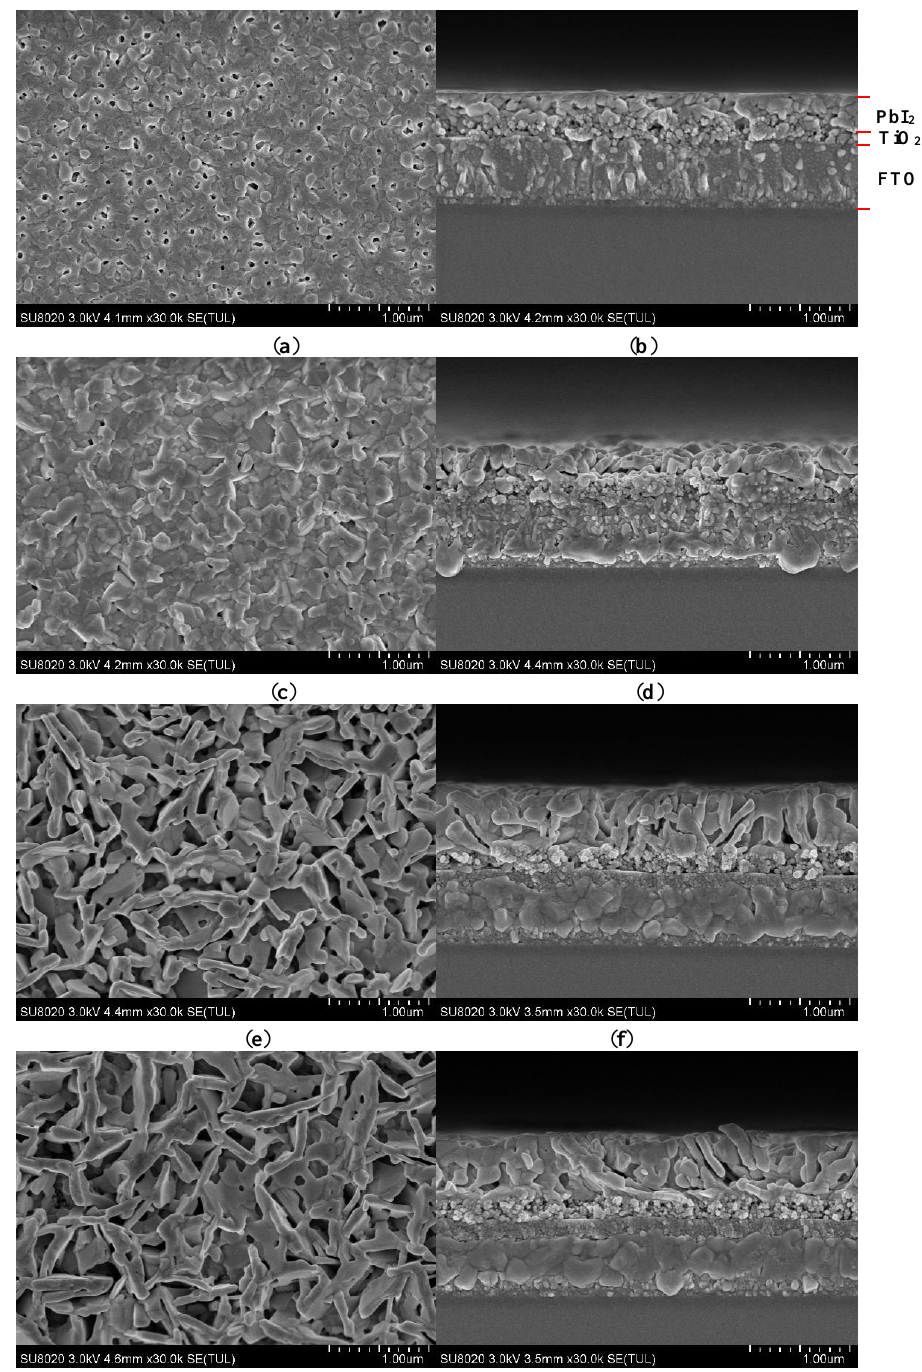
Figure 1. SEM image of surface and cross-section of PbI 2 films with different K + concentrations: ( a ), ( b ) PbI 2 ; ( c ), ( d ) PbI 2 +0.04KI; ( e ), ( f ) PbI 2 +0.08KI ;( g ), ( h ) PbI 2 +0.12KI.